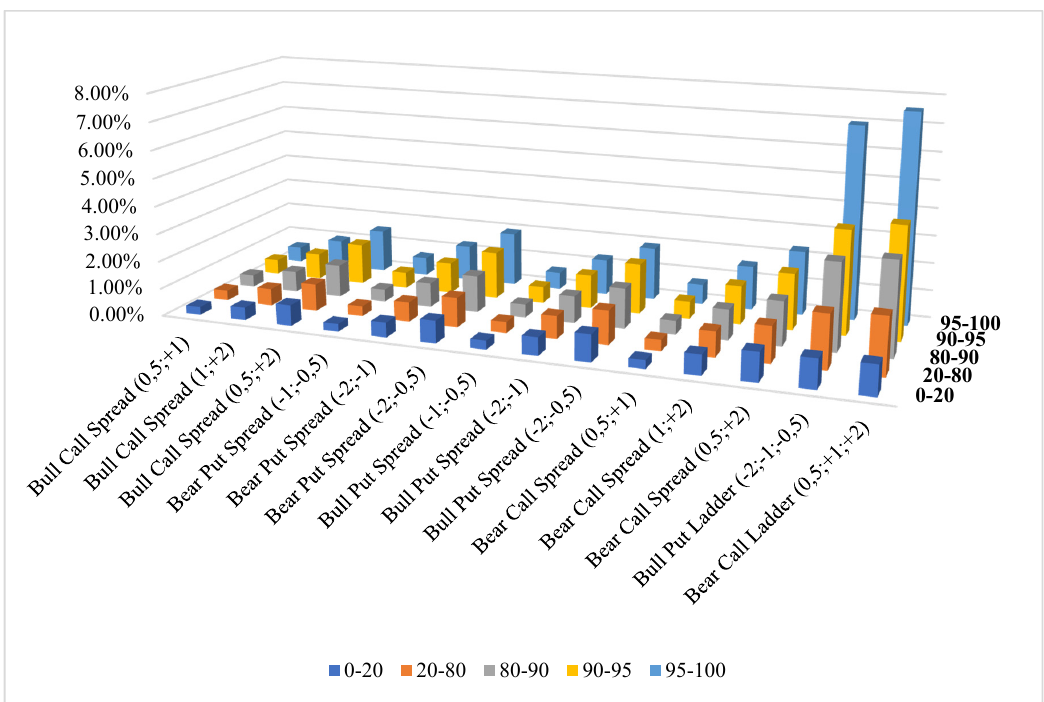
Figure 5. Mean costs for vertical spread option strategies (% of ATM strike price). Table 4. Price ranges in which the individual variants of vertical spreads generated a